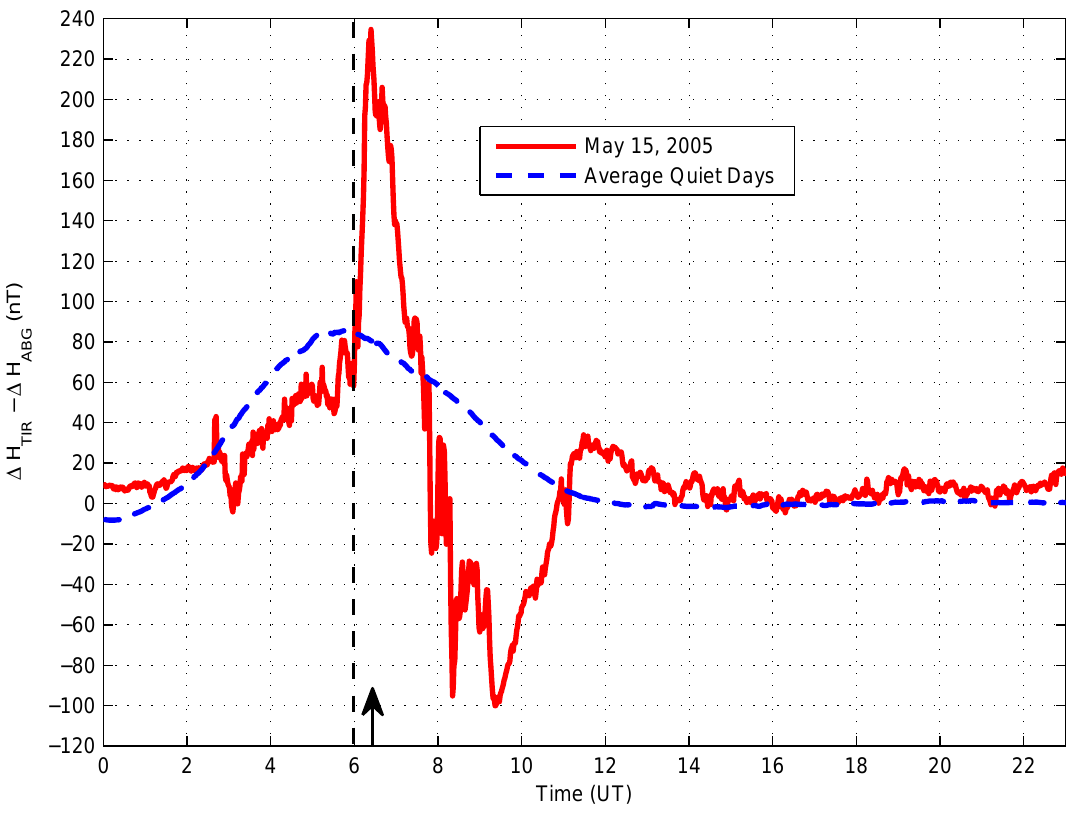
Fig. 2. The ( 1H TIR − 1H ABG ), estimated using Tirunaveli (equatorial) and Alibagh (non-equatorial) magnetometer data with 1min resolu- tion. Variation on 15 May 2005 (red solid line) and for mean of quiet days (blue-broken line) are shown for comparison. The vertical dashed line at 06:00UT represent the time of PP of electric field and the vertical arrow at about 06:30UT shows the sudden reversal in the quantity.